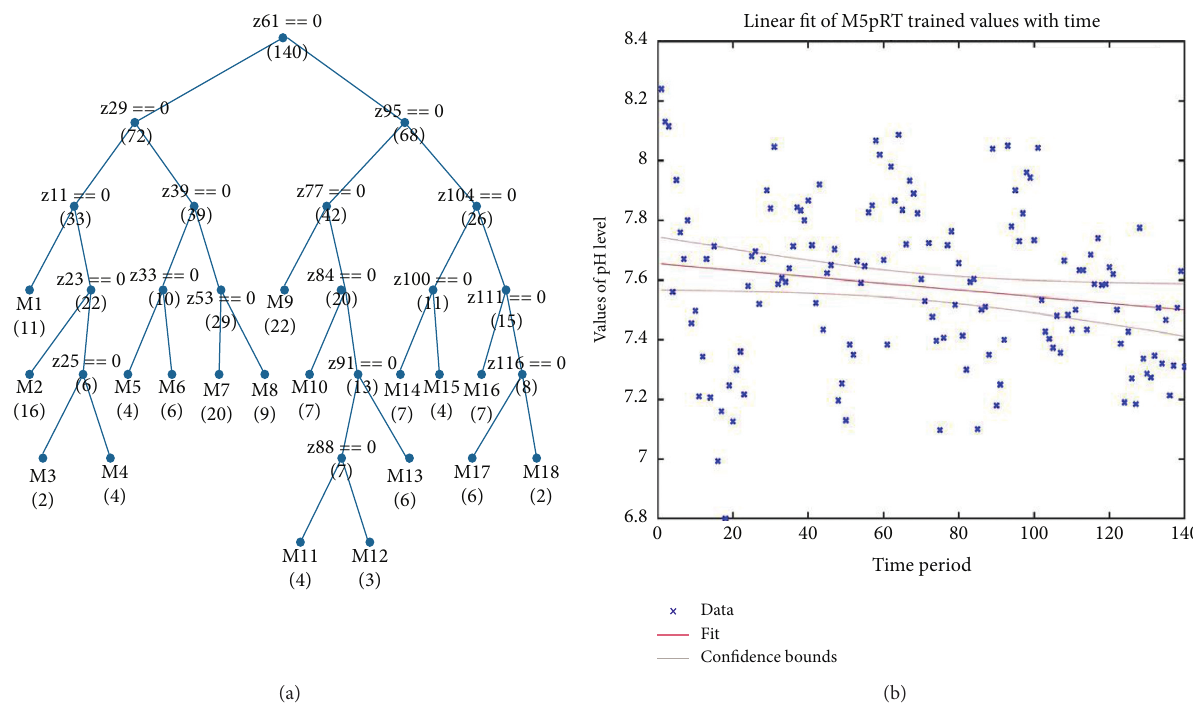
Figure 14: (a) Regression tree simulated via M5pRT at Bridge. (b) Linear regression fit of M5pRT trained data at